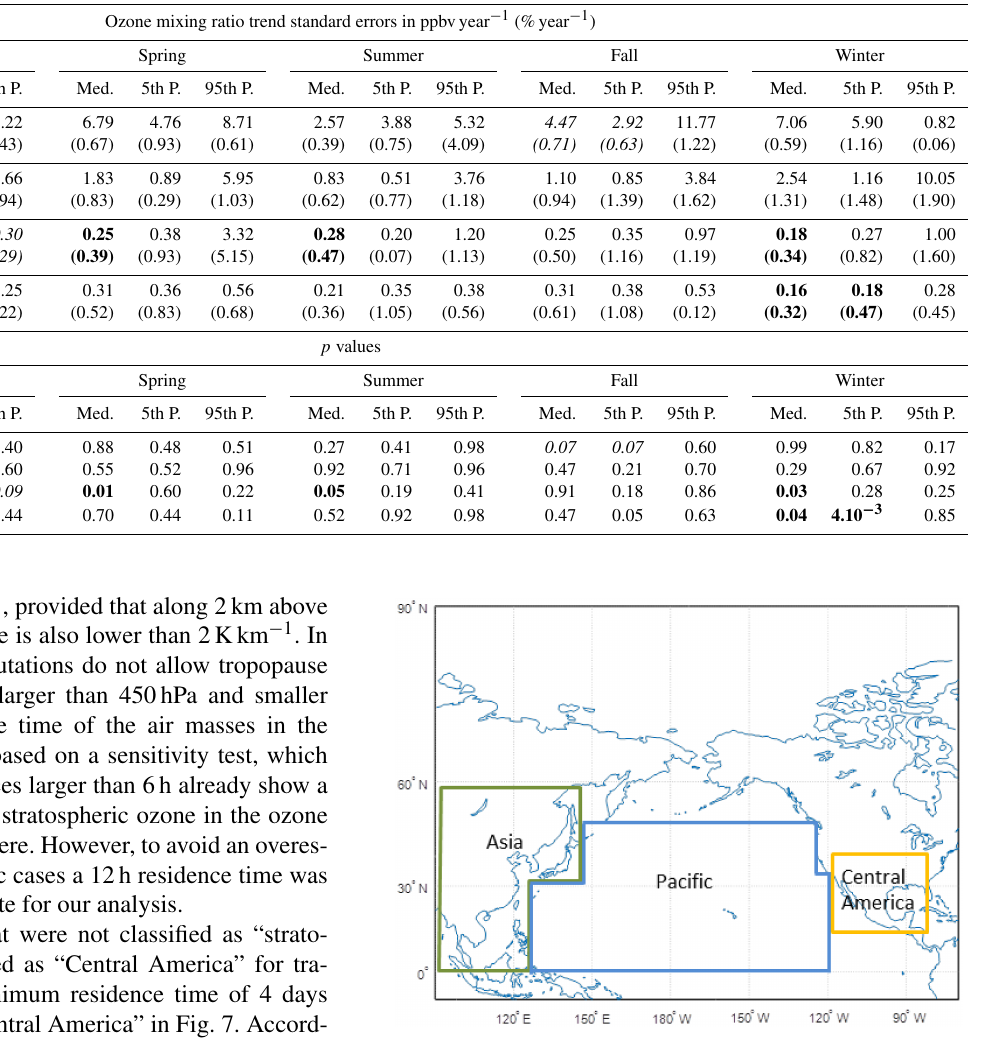
Table 3. Standard errors in ppbvyear − 1 and p values associated with ozone mixing ratio trends for the median, 5th and 95th percentiles (P. is percentiles in table) included in Table 2 and shown in Fig. 6. Data corresponding to statistically significant trends at 95 and 90% confidence level are marked in bold and italic font, respectively.